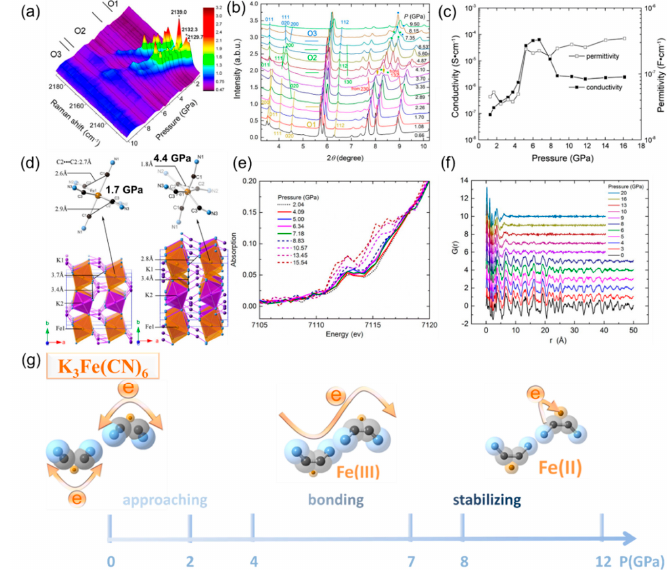
Figure 6. ( a ) In situ Raman spectrum of K 3 Fe(CN) 6 under high pressure up to 10 GPa [70]. ( b ) Selected in situ X-ray diffraction patterns of K 3 Fe(CN) 6 , the peaks of O1-O3 are marked by yellow arrows, green stars, and blue squares, respectively [70]. ( c ) Electronic conductivity and permittivity of K 3 Fe(CN) 6 under high pressure [70]. ( d ) Crystal structure of K 3 Fe(CN) 6 and local structure of Fe(CN) 63